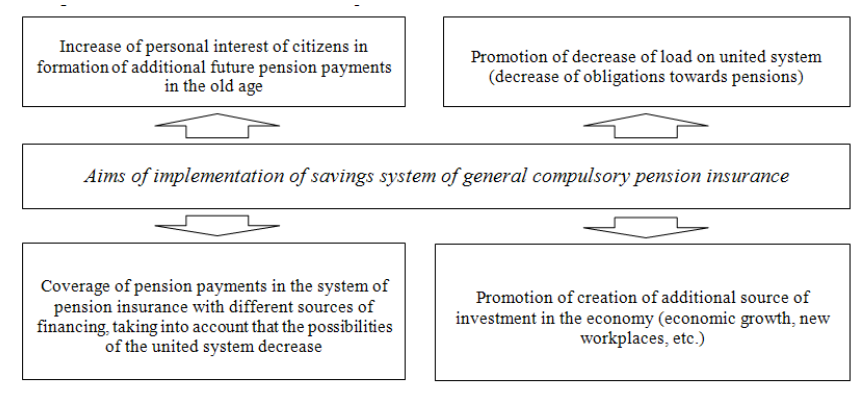
Fig. 5. Aims of implementation of savings system of general compulsory pension insurance (of (cid:561)(cid:561)